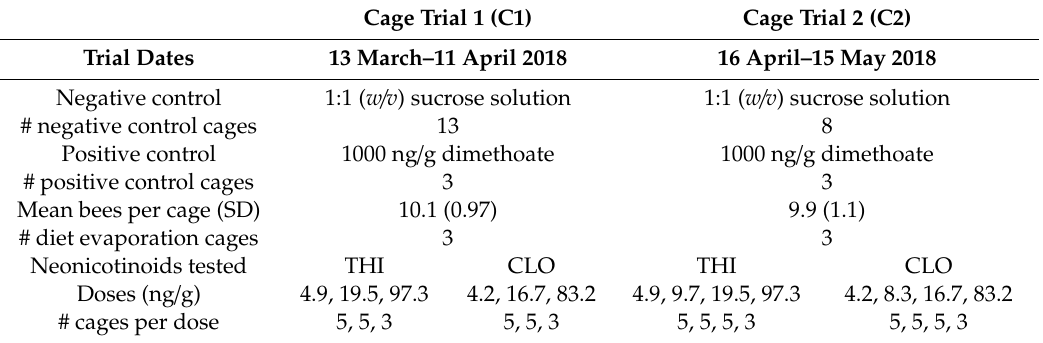
Table 2. Experimental design of laboratory cage trials examining survival of winter honey bee workers chronically exposed to thiamethoxam (THI) or clothianidin (CLO) for 30